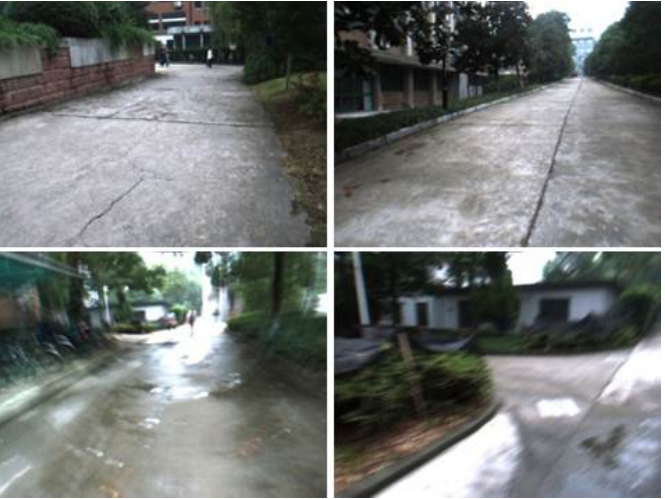
Figure 13. Image samples on dataset1.